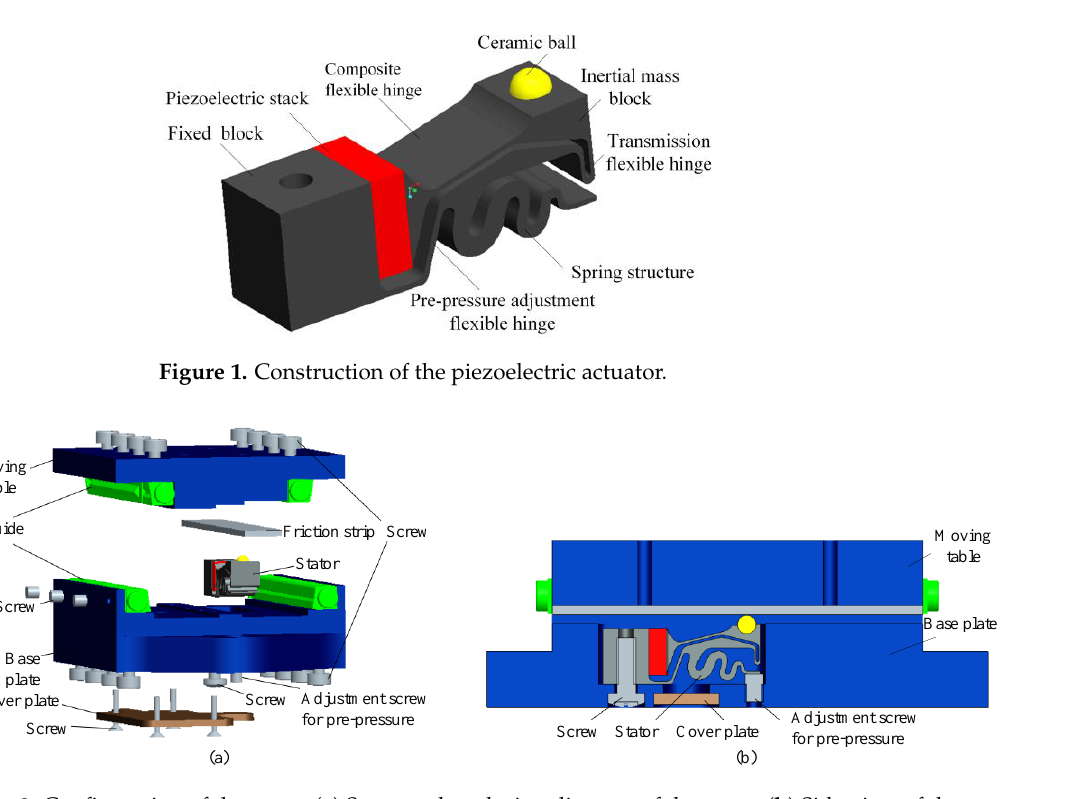
Figure 2. Configuration of the stage. ( a ) Structural explosion diagram of the stage. ( b ) Side view of the stage.